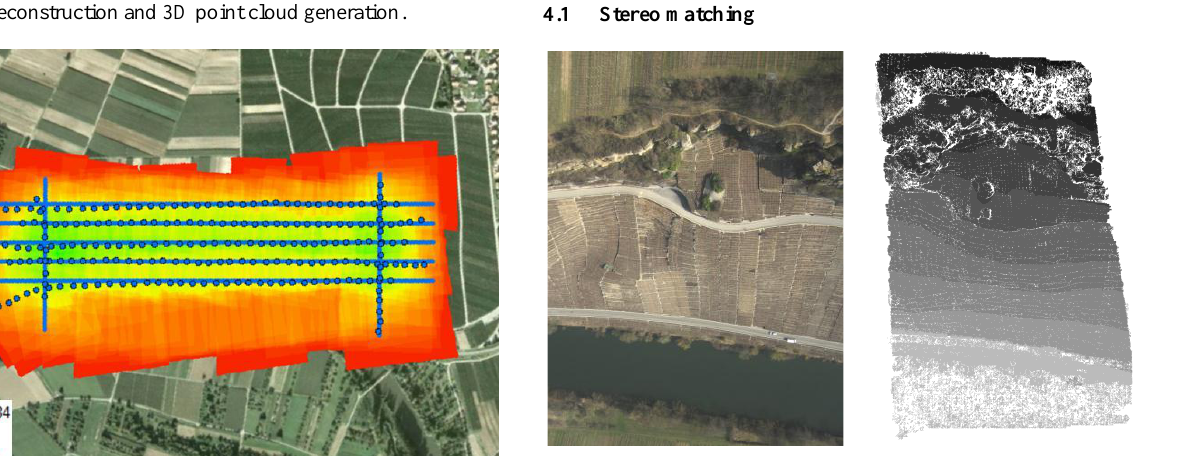
Figure 7: Stereo and corresponding parallax image for Figure